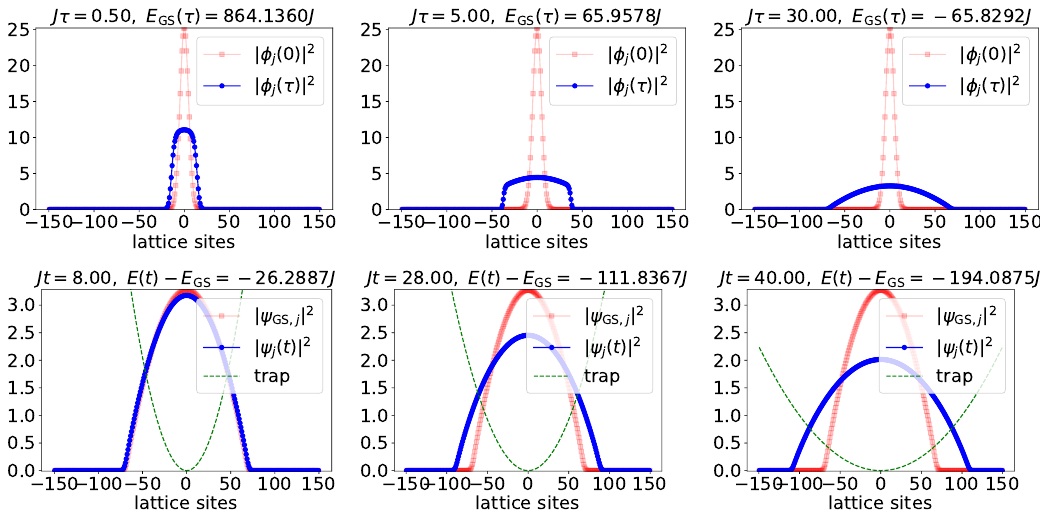
Figure 5: Top row: three snapshots of the imaginary time dynamics which turns the non-interacting ground state into the GPE ground state at long imaginary times. Bottom row: three snapshots of the real-time evolution induced by slowly widening the harmonic trap strength. The pale red curve is the initial state, while the blue curve shows the instantaneous state. The harmonic trap is shown with a dashed green